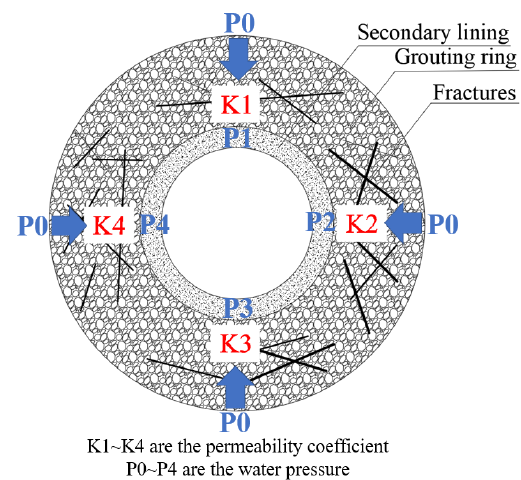
Figure 16. Description of the principle of water pressure characteristics.